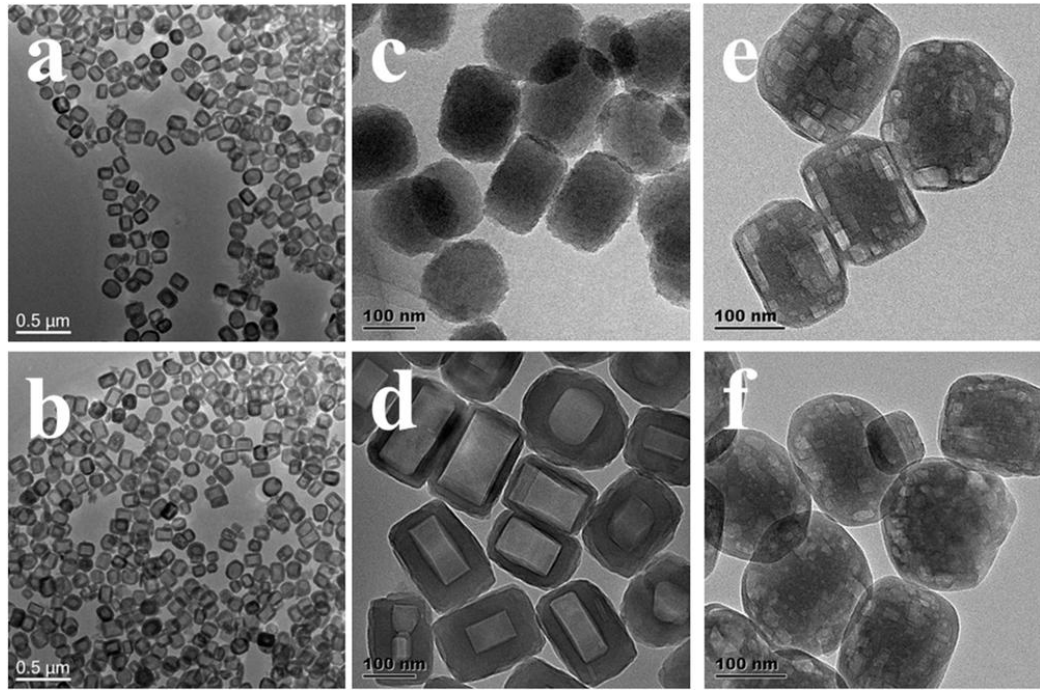
Figure 2. TEM images of ZSM-5 with different parent Si/Al ratios after TPAOH treatment at 170 °C for 72 h. ( a , b ) The parent Si/Al ratio is 40, and the concentrations of TPAOH are 0.1 and 0.2 M, respectively. ( c , d ) The parent Si/Al ratio is 59, and the concentrations of TPAOH are 0.1 and 0.2 M, respectively. ( e , f ) The parent Si/Al ratio is 79, and the concentrations of TPAOH are 0.2 and 0.5 M, respectively [22]. Copyright Wiley-VCH Verlag GmbH and Co., 2015.